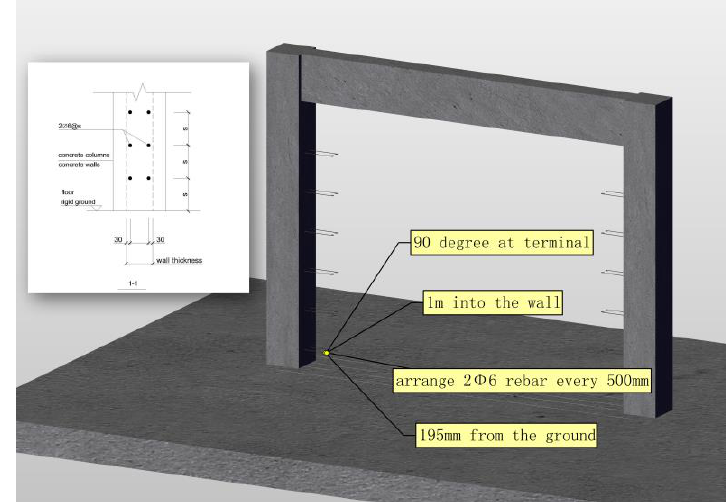
Figure 8. Process mapping of key views for planting a reinforcing bar in the wall.